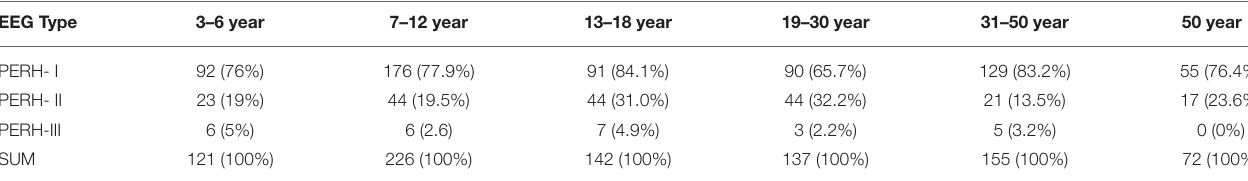
FIGURE 2 | Frequency distribution (%) of patients by pathological EEG responses to hyperventilation (PERH) types for various age groups in Group A. A majority of patients developed PERH-I followed with PERH-II ( p < 0.05) irrespective of age. TABLE 2 | Frequency distribution of patients by PERH type and age in Group